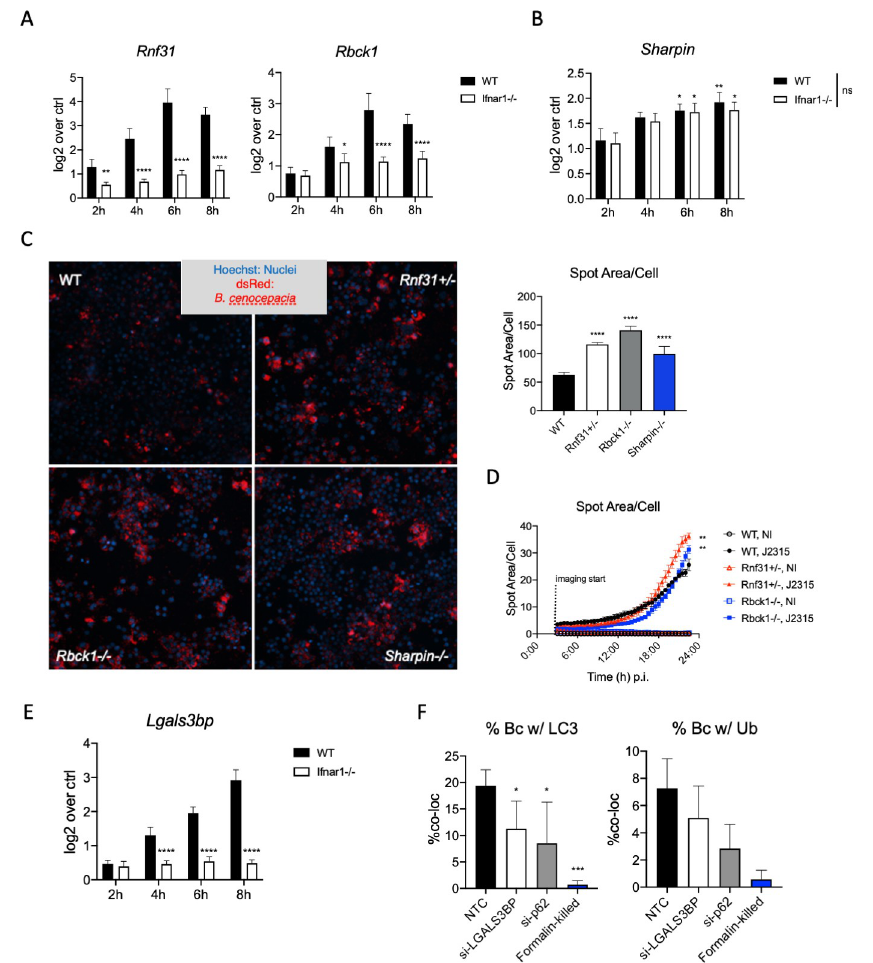
Fig 5. ISGs play a critical role in the transition to autophagy during intracellular bacterial infection. A,B) WT and Ifnar1 -/- iBMDMs were infected with wt Bc (MOI = 1) for given amounts of time before RNA was extracted. A) Rnf31 , Rbck1 , or B) Sharpin transcription was measured by RT-PCR and normalized to Hprt in uninfected cells. n = 5 for each timepoint, representative of 2 independent experiments. C) WT, Rnf31 +/- , Rbck1 -/- , and Sharpin -/- RAW264.7 cells were infected with dsRed+ Bc (MOI = 1) for 22 h before fixing with PFA. Bacterial fluorescence was analyzed by high-content imaging using dsRed fluorescence. D) WT, Rnf31 +/- , and Rbck1 -/- RAW264.7 cells were infected with dsRed+ Bc (MOI = 1) and bacterial fluorescence was measured every 30 min for 22 h by live-cell high-content imaging. Infection experiments have n = 5 and are representative of 3 independent experiments. E) WT and Ifnar1 -/- iBMDMs were infected with wt Bc (MOI = 1) for given amounts of time before RNA was extracted. Lgals3bp transcription was measured by RT-PCR and normalized to Hprt . n = 5, representative of 2 independent experiments. F) PMA- differentiated THP-1 cells were infected with Bc for 6h before fixing and staining for LC3B and total ubiquitin. Co- localization of Bc with LC3 or Ub were enumerated by high-content imaging followed by spot detection analysis. Co- localization experiments were done with n = 5, and are representative of 2 independent experiments. � = p � 0.05, �� = p � 0.01, and ���� = p � 0.0001 by Mann-Whitney U test. Comparisons in 5B are between individual groups with their respective unstimulated cells (i.e. WT vs. WT, KO vs. KO). There were no significant differences between WT and KO responses for this